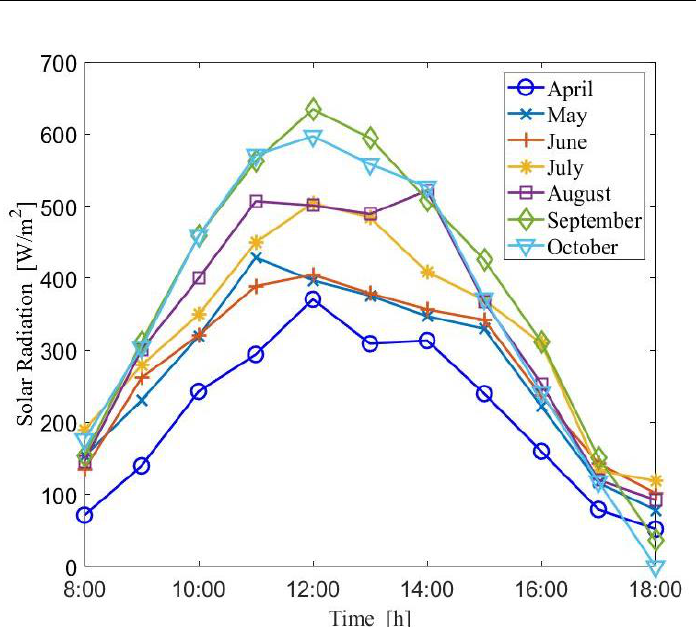
Figure 6. Solar radiation.